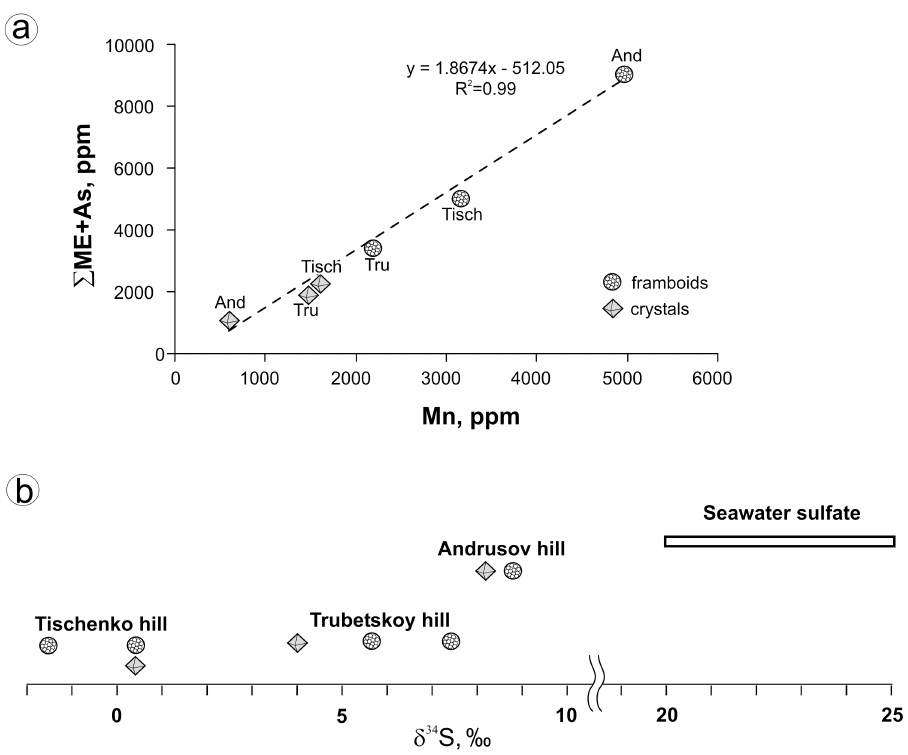
Figure 15. Trace element loading ( a ) and stable sulphur isotope composition ( b ) of pyrite from the MMS. ME = V + Cr + Mn + Co + Ni + Cu + Zn + Mo + Cd + Sb + Au + Pb. Sulphur isotope composition of sea water sulfate after [42].